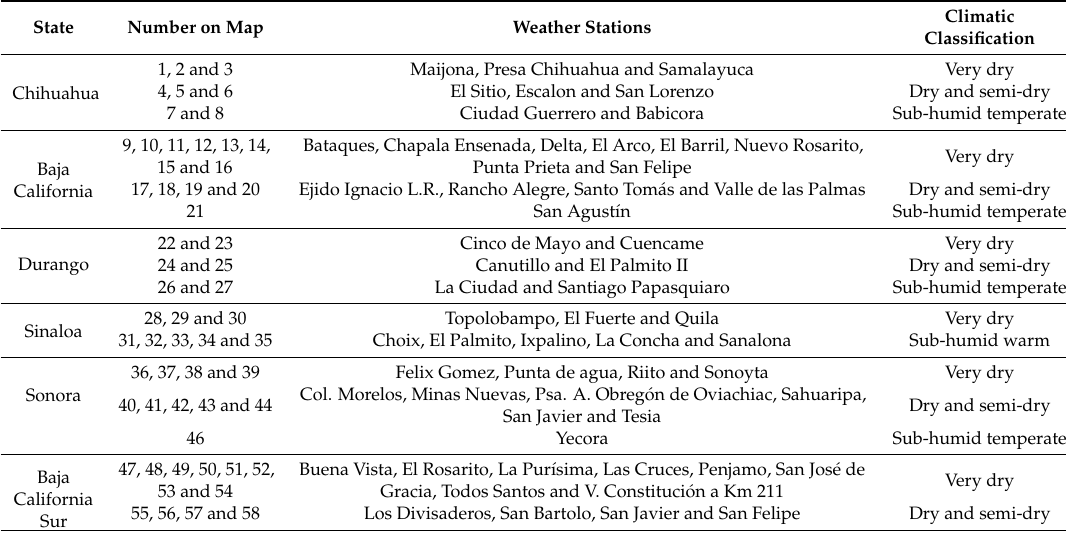
Table 2. Climatic classification and location of weather stations in six states in northern Mexico. Source: Authors, following CLICOM (2018) and INEGI (2018)